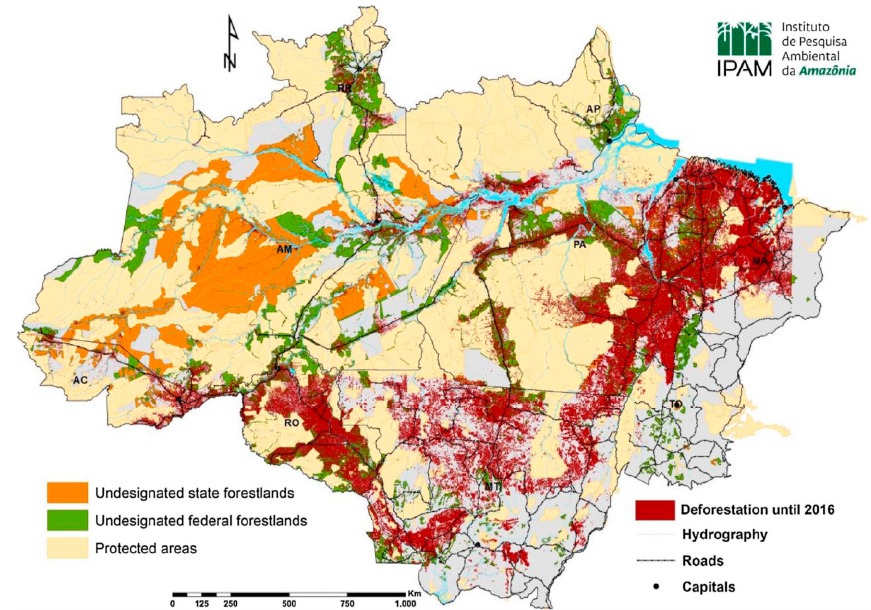
Figure 2. Public forests of the Brazilian Legal Amazon and its 70 million hectares of undesignated forestlands [15].